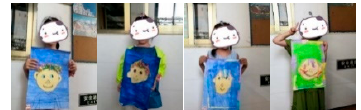
Figure A1. Identification map of happiness, anger, sadness, and joy.